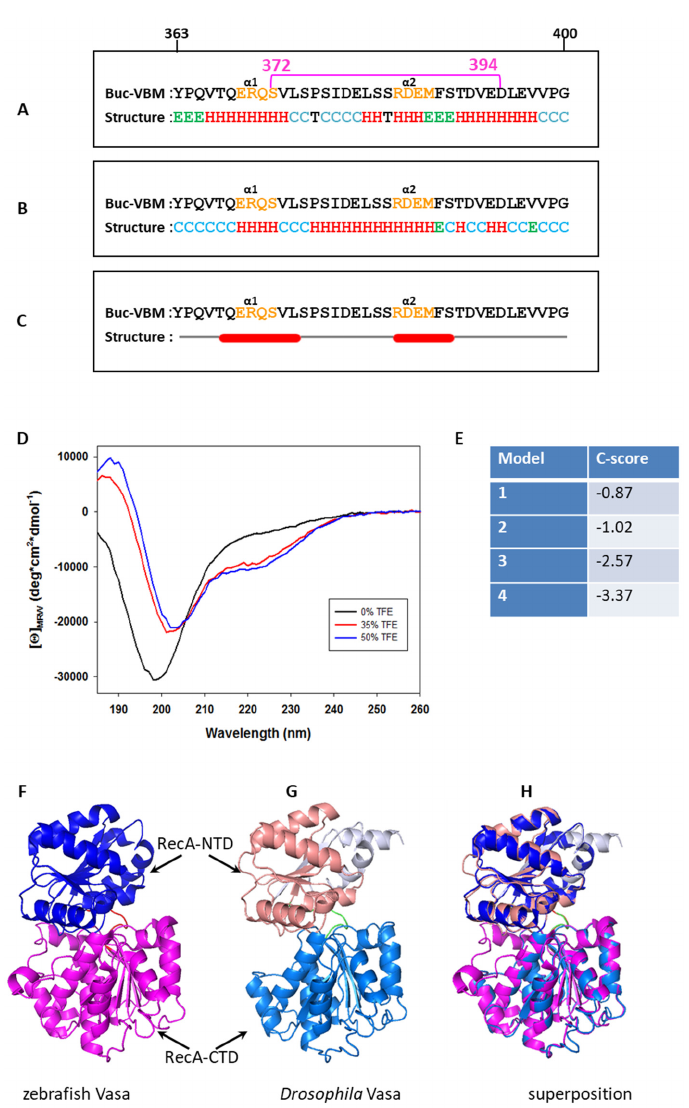
Figure 3. Buc-VBM adopts α -helices from its disordered nature in vitro. ( A ) In silico prediction of α -helices in Buc-VBM. In all three algorithms, the predicted α -helices are denoted as ‘H’ in red, β -sheets as ‘E’ in green, and turns as ‘T’ in black. The consensus secondary structure is shown at the bottom. Note that random coils in the consensus structure are denoted as ‘C’ in light blue. The first (363) and last (400) amino acids of Buc-VBM are displayed on top of the sequence ( A – C ). The highly conserved amino acids 372–394 are denoted by a pink, horizontal bar. ( A ) Secondary struc- ture prediction using the CFSSP algorithm. The algorithm predicted two α -helices, α 1 and α 2. The α 1-helix contains the amino acid sequence ERQS (orange), and α 2 contains the amino acid RDEM (orange). CFSSP also predicted two β -sheets (green E), which contain the amino acids YPQ at the N-terminus and MFS at the C-terminus. ( B ) Secondary structure prediction using the PEP2D algo- rithm. The algorithm predicted two α -helices, α 1 and α 2, which share the same amino acids pre- dicted by the CFSSP algorithm. ( C ) Secondary structure prediction using the Jnet algorithm. The